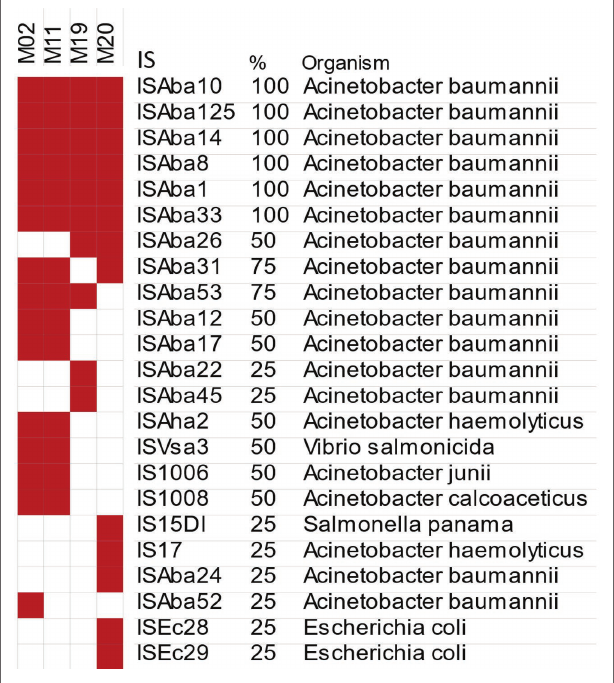
FIGURE 3 | Genome-wide distribution of different IS elements in the bla NDM - positive isolates predicted by ISfinder. Red and white colors denote the presence and absence of each IS element, respectively.